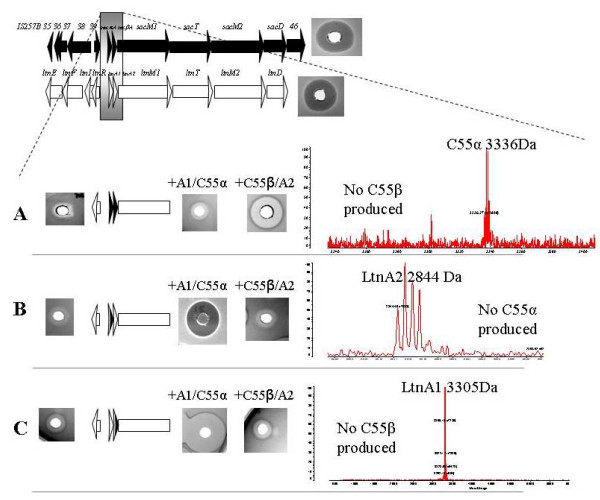
Genetic replacement study of combinations of the lacticin 3147 structural genes for the staphylococcin C55 structural genes on pMRC01. Genetic organization of S. aureus C55 pETB plasmid (gene cluster of staphylococcin C55) is represented by black arrows and L. lactis DPC3147 pMRC01 (gene cluster of lacticin 3147) is represented by white arrows. A. MG1363 pMRC01 with ltnA1A2 genes exactly replaced with staphylococcin C55 structural genes, sacαAsacβA, this construct is called Mutant A. B. MG1363 pMRC01 with ltnA1 structural gene exactly replaced by sacαA structural gene, this construct is called ltnA1/Sacα Hybrid. It also contains the wild type ltnA2 gene. C. MG1363 pMRC01 with ltnA2 structural gene exactly replaced by sacβA structural gene, this construct is called ltnA2/Sacβ Hybrid. It also contains the wild type ltnA1 gene. The well diffusion assay on the left of the constructs shows activity of a purified preparation (through a Varian C18 column) of the construct alone and the well diffusion assays on the right hand side shows activity after complementation with purified lacticin 3147 or staphylococcin C55 peptides. Mass spectrometry analysis of the constructs indicates the mass of the peptides produced. The scale of the y-axis of the mass spec. is A) 2800–3600 mass/charge, B) 2300–3700 mass/charge and C) 2700–4000 mass/charge.